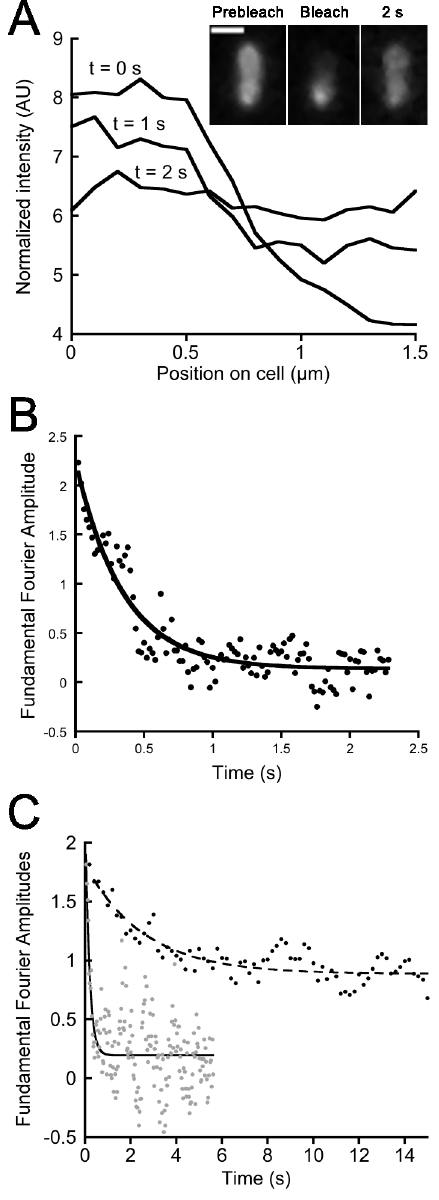
Figure 2. Illustration of FRAP data treatment for PvdQ- mCHERRY and comparison of the fast diffusing of PvdS-YFP with the slow diffusing TonB-mCHERRY. A. One-dimensional profiles along the long cell axis after photobleaching (t=0 s), during recovery (t=1 s) and after full recovery (t=2 s) of strain pvdQ-mcherry . Inset: Fluorescence images extracted from the acquired FRAP stream. From left to right: before photobleaching, after photobleaching and after recovery. B. Experimental Fourier amplitudes for mode n=1 as a function of time of PvdQ-mCHERRY and the fitted exponential decay (solid line) used to determine the diffusion coefficient. C. Experimental Fourier amplitudes for mode n=1 as a function of time for PvdS-YFP (gray circles) and TonB-mCHERRY (black circles) and the corresponding fitted exponential decay (hashed and solid lines, respectively). doi:10.1371/journal.pone.0079111.g002 biosynthesis of proteins. The diffusion constants we determined, and the levels of fluorescence recovery, for the various strains are summarized in Table 2 .